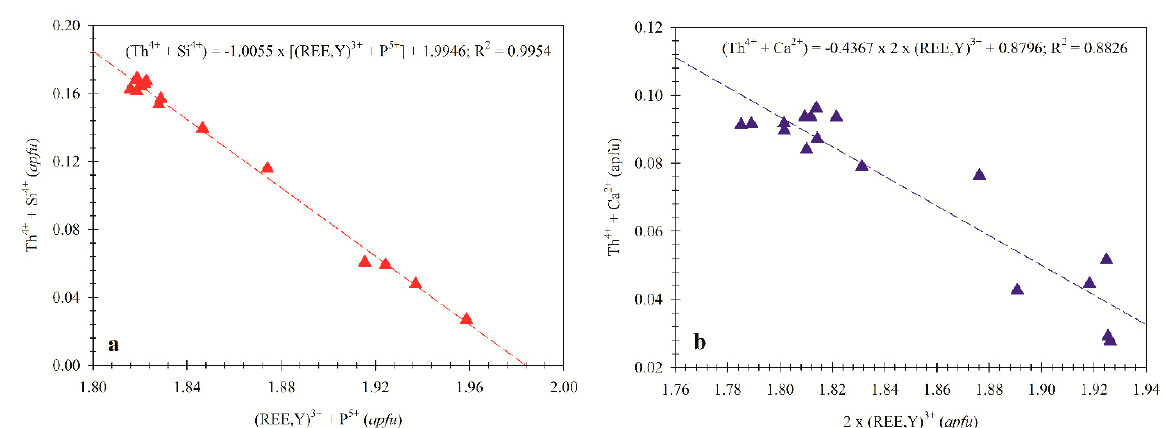
Figure 3. Compositional exchanges in sample 2a. Two exchanges are shown: ( a ) (REE,Y) 3+ + P 5+ ↔ Th 4+ + Si 4+ (huttonite substitution) and ( b ) 2(REE,Y) 3+ ↔ Th 4+ + Ca 2+ (cheralite substitution).